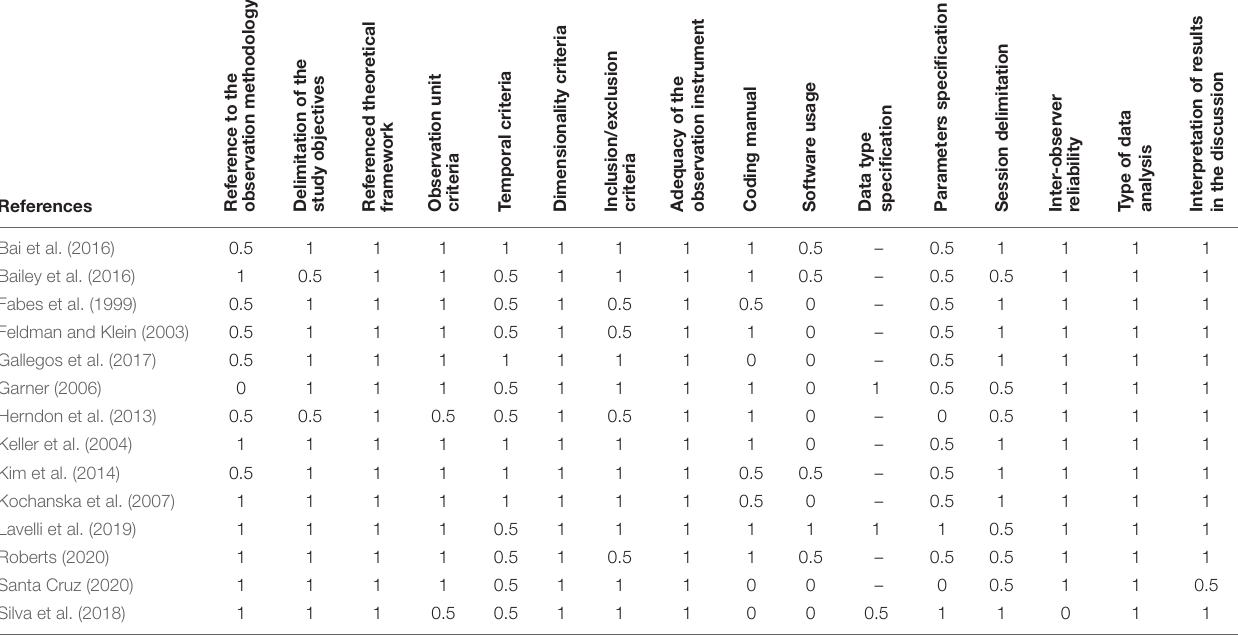
TABLE 7 | Methodological characteristics observed using the Methodological Quality Checklist for studies based on Observational Methodology